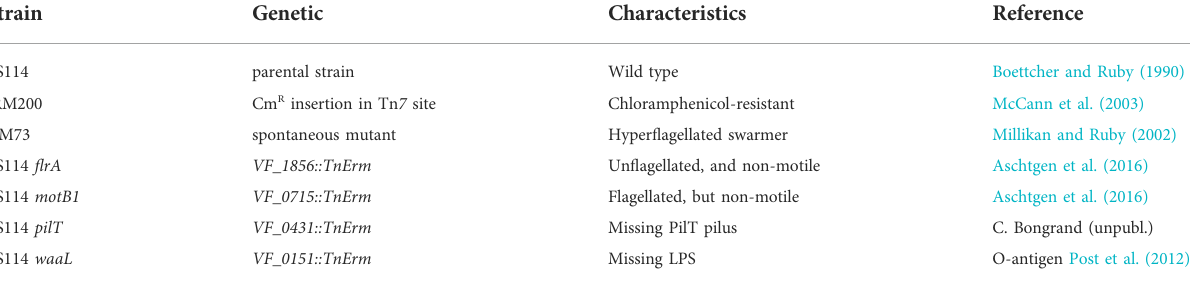
TABLE 1 Derivatives of Vibrio fi scheri strain ES114 used in this study.